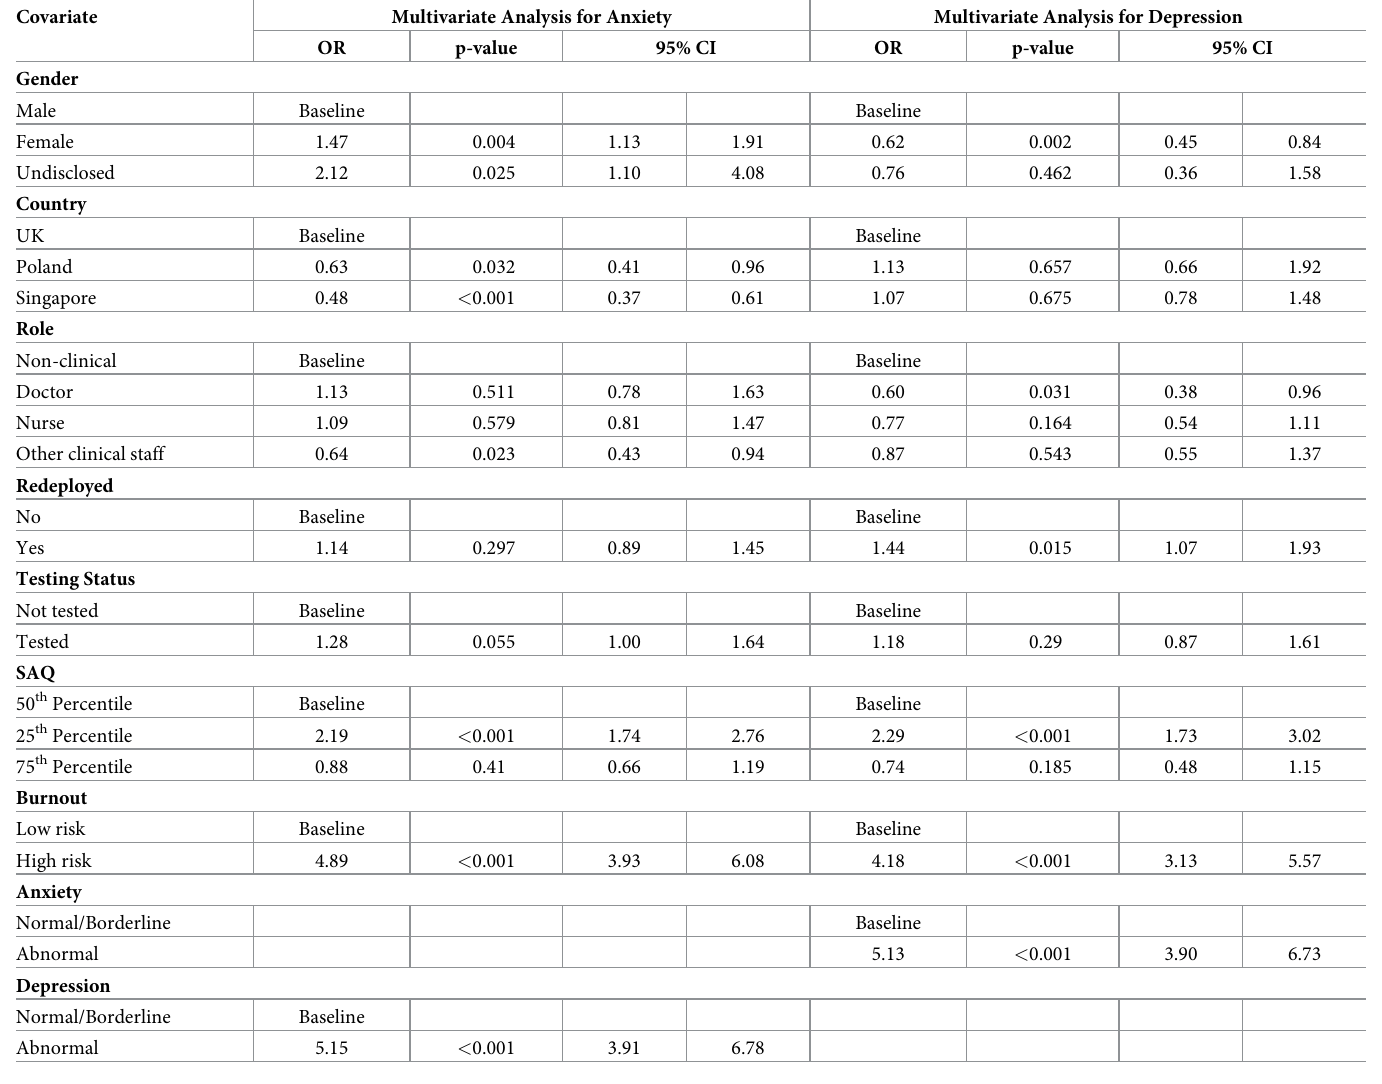
Table 4. Multivariate analyses with anxiety and depression as dependent